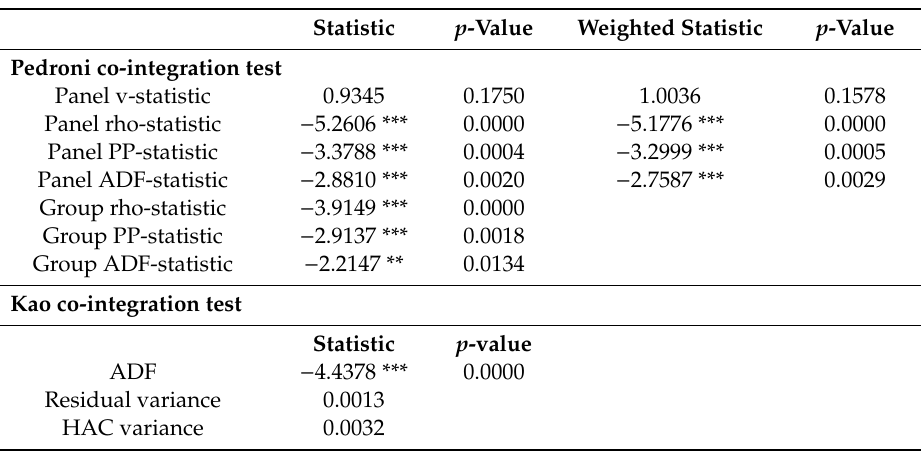
Table 3. Co-integration test